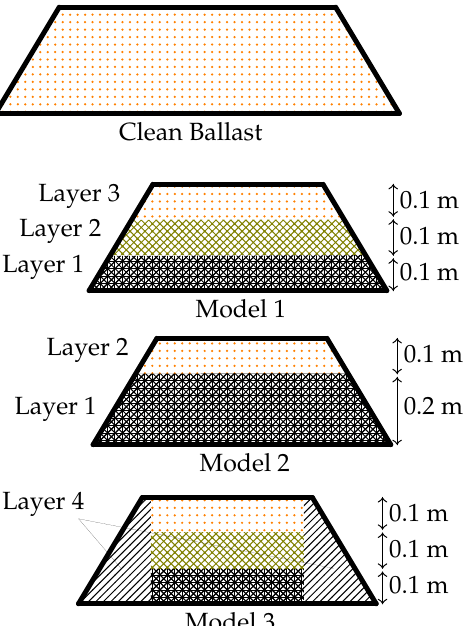
Figure 12. The railway ballast geometry following the Australian track dimensions [3].